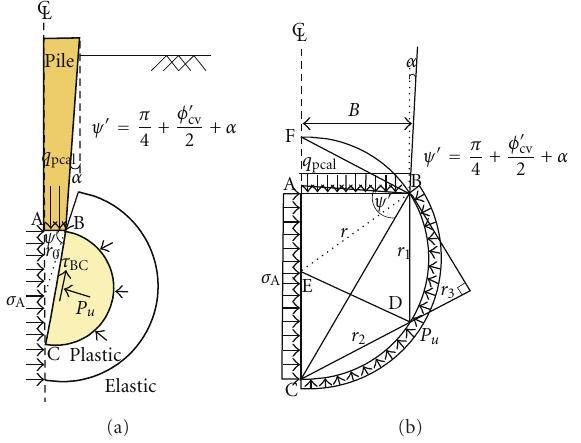
Figure 4: (a) Concept of modified failure mechanism around the tapered pile tip in cavity expansion solution and (b) geometry of calculation procedure to find ultimate end-bearing capacity of tapered